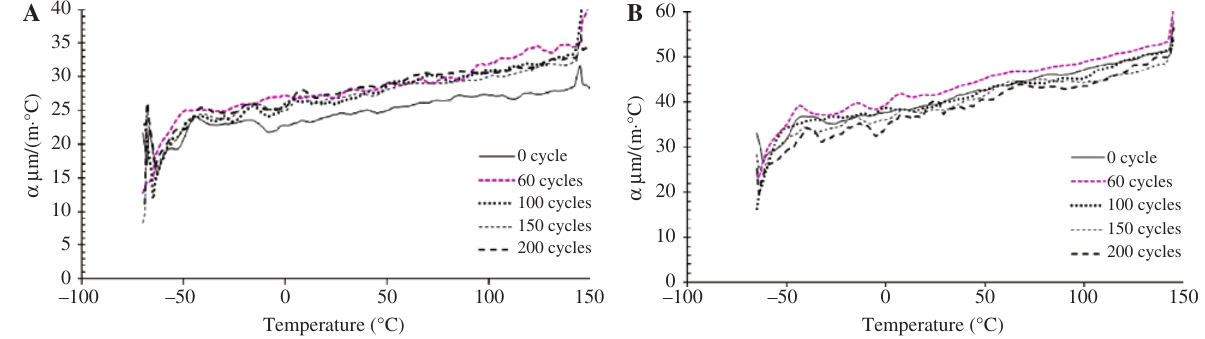
Figure 8: Effect of thermal cycling on through-the-thickness CTE of the (A) UD composite and (B) fabric